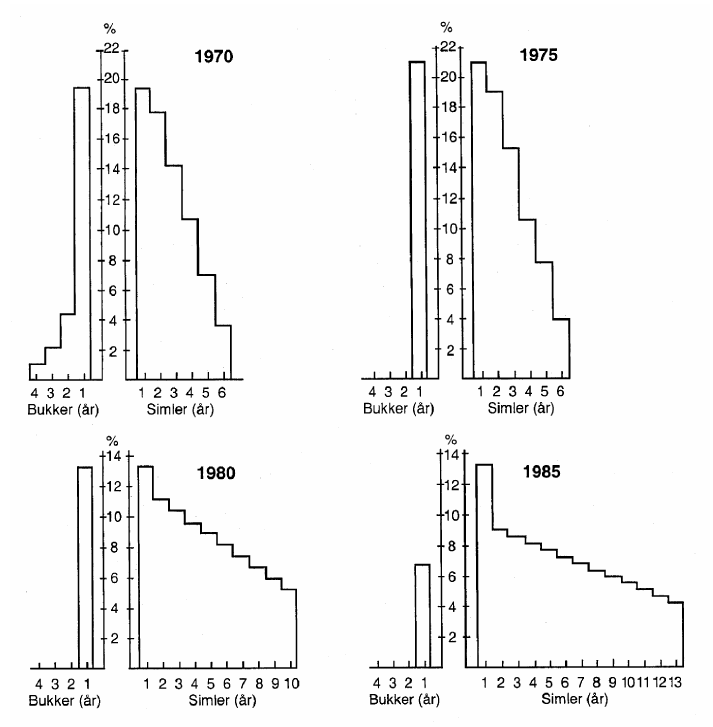
Fig. 2. Endringen av kjønns- og aldersfordelingen i vårflokken i Riast/Hylling i løpet av de 15 årene utviklings- og forskningsarbeidet foregikk (Lenvik,